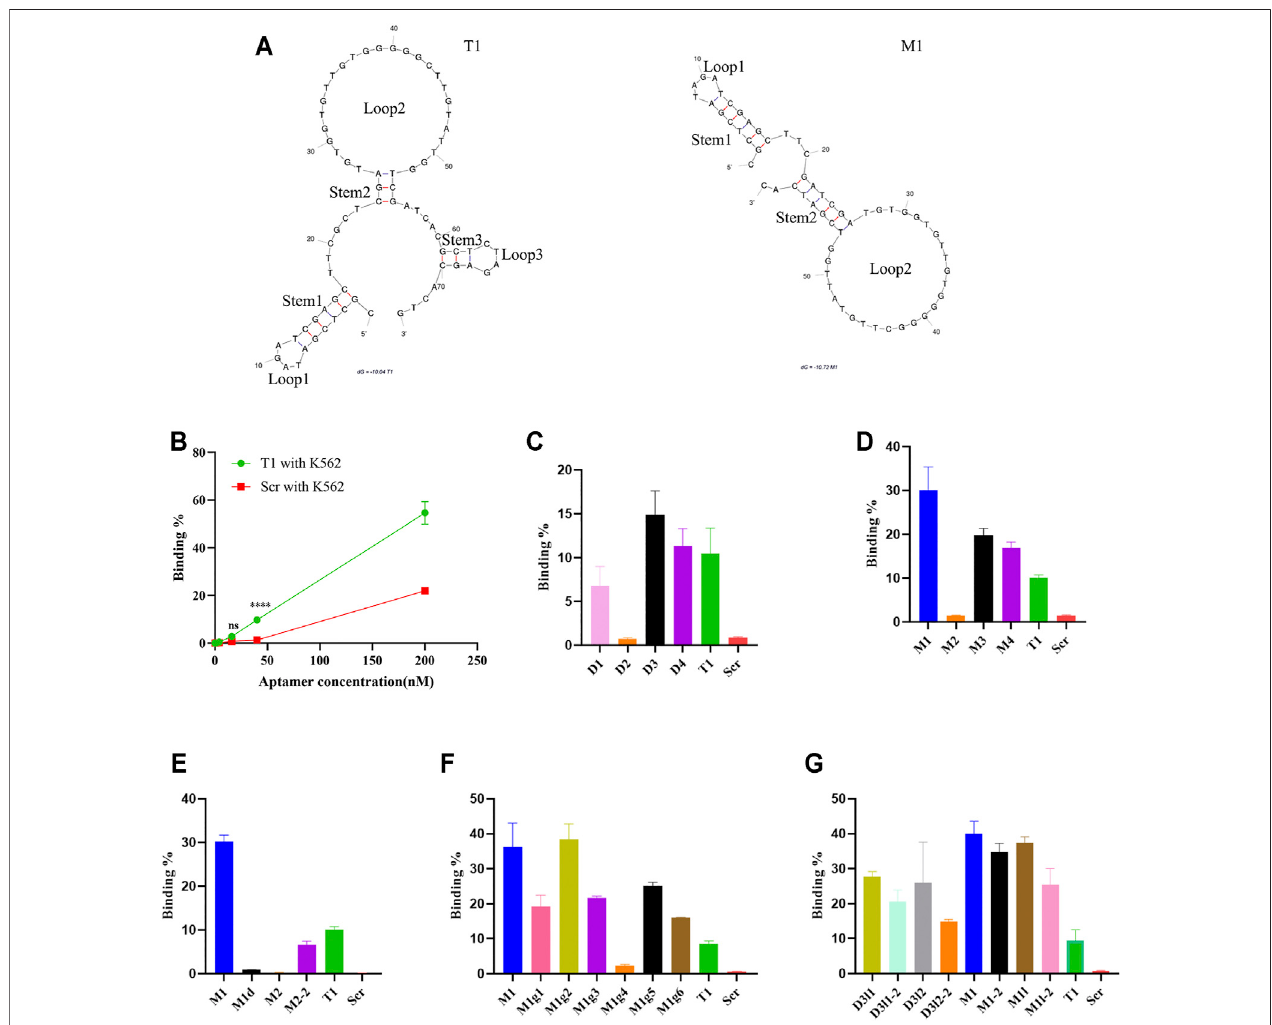
FIGURE2| AnalysisofaptamerbindingtoK562cells. (A) PredictedsecondarystructuresofT1andM1aptamers.Stemsandloopsintheaptamerarelabeled. (B) Dose-dependent binding of aptamers to K562 cells based on fl ow cytometry analysis. (C – G) Flow cytometry analysis on binding of K562 cells by T1 and derived